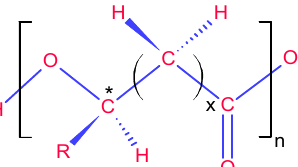
Figure 1. The general structure of a polyhydroxyalkanoate (PHA) macromolecule. All monomeric units have one chiral centre (*) with the configuration of the R enantiomer, and the whole macromolecule has a perfect isotactic structure [12]. The number of carbon atoms in the R substituent ranges up to 18 [13]; x ranges from 1–3, and n ranges from 100–30,000 [3,14]. For poly(3-hydroxybutyrate) (P3HB), R = CH 3 and x = 1; for poly(3-hydroxyvalerate) (P3HV), R = C 2 H 5 and x = 1; etc.